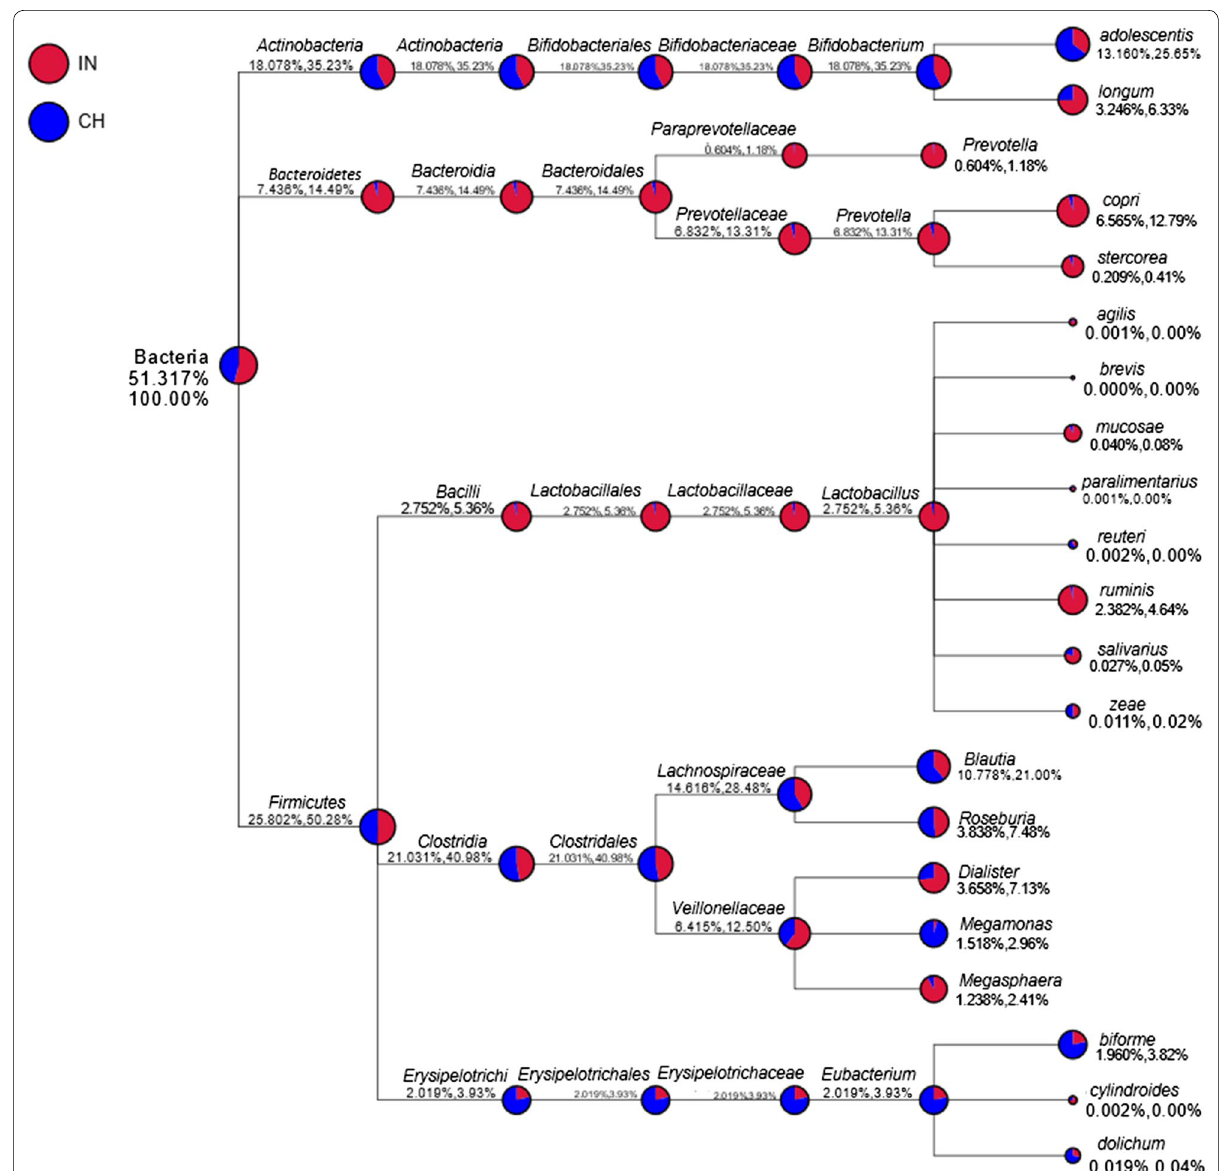
Fig. 1 Taxon composition profile of Indian and Chinese gut bacteria. The numbers after the taxonomic ranks are the relative abundances of the corresponding taxon in gut